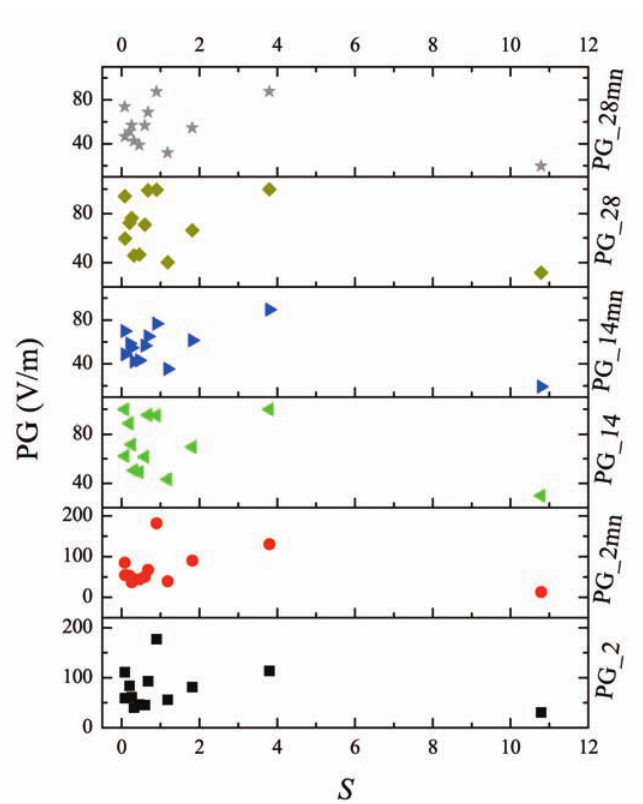
Figure 3. The PGs for the different averages considered in this study (PG_2,